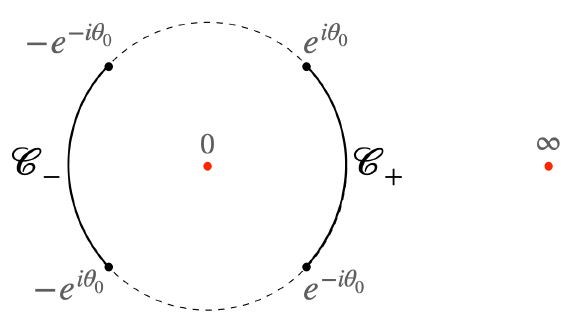
Figure 2 . Analytic structure of p cl ( x ) . It has two branch cuts C ± , around which the integral H p ( x ) du gives − J , as well as two poles at x = 0 and x = ∞ , around which H p cl addition, p = π at the right branch points, e ± iθ , and p cl